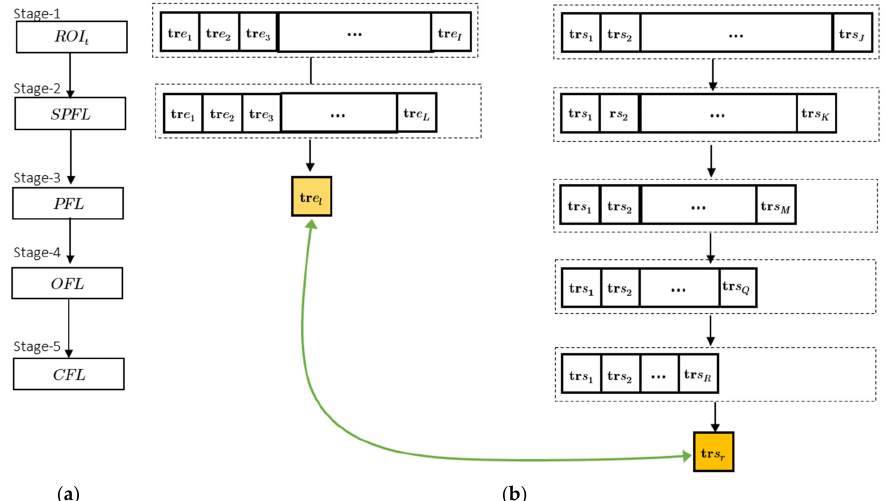
Figure 2. One single KLT tracklet 𝐭𝐫 (cid:3041) with its initial and final lifetime points.